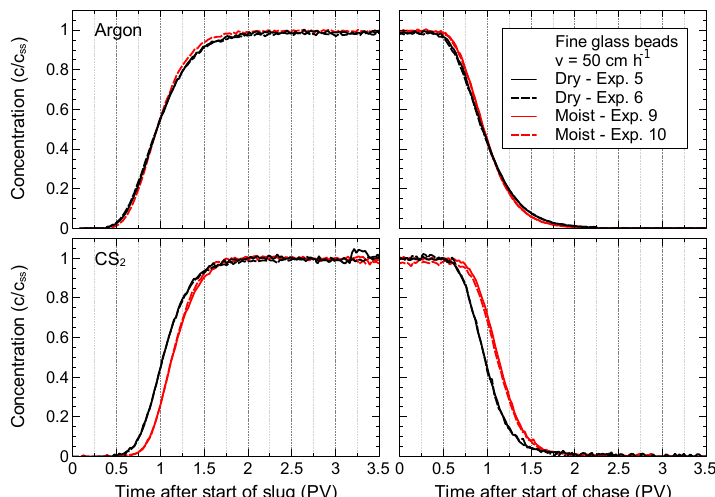
Figure 6. Breakthrough curves of CS 2 and Ar in dry and moist ( S w = 0.088) fine glass beads under identical slug and flow conditions ( v = 50cmh − 1